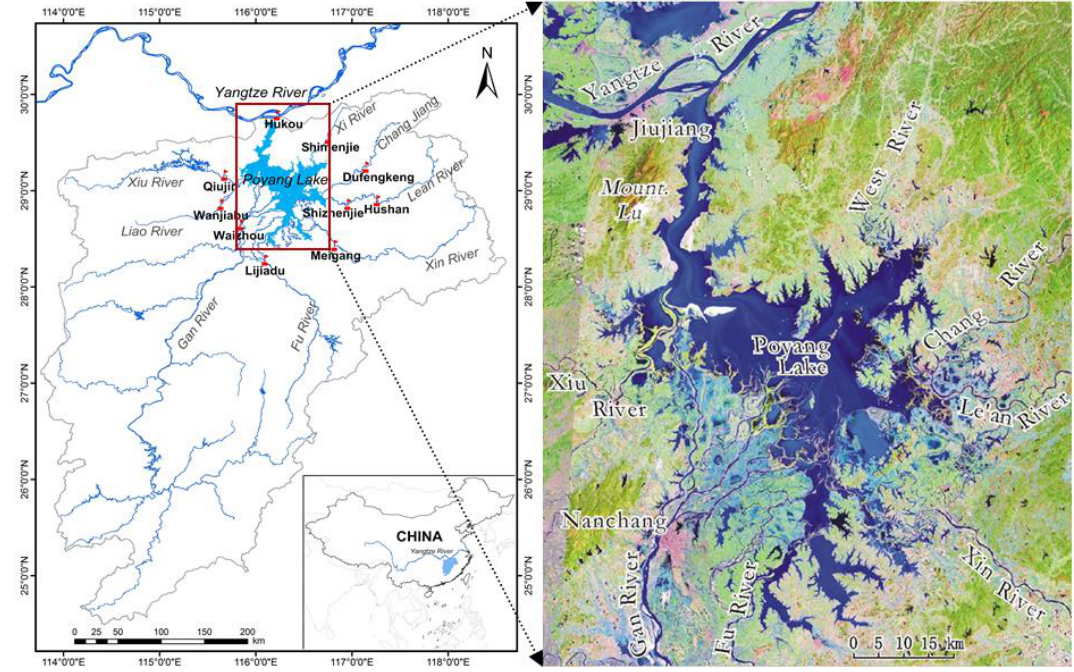
Figure 1: The hydrological system for Poyang Lake watershed and map of Poyang